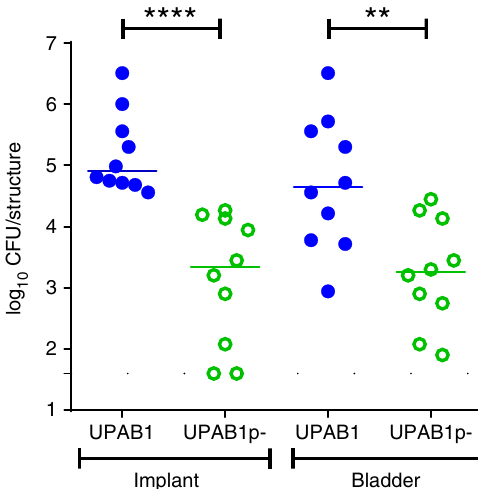
Fig. 4 pAB5 is required for the establishment of CAUTI. Each symbol represents an individual mouse. Data shown are pooled from two independent experiments with fi ve mice. For each strain, the median value is shown as the horizontal line. Statistical analyses were performed